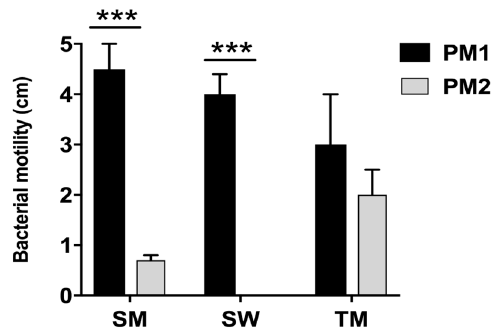
Figure 4. Evaluation of swimming (SM), swarming (SW) and twitching (TM) motility in PM1 and PM2. Data are mean ± SD. Significant differences are indicated by *** p < 0.001 for comparison of PM1 vs. PM2.